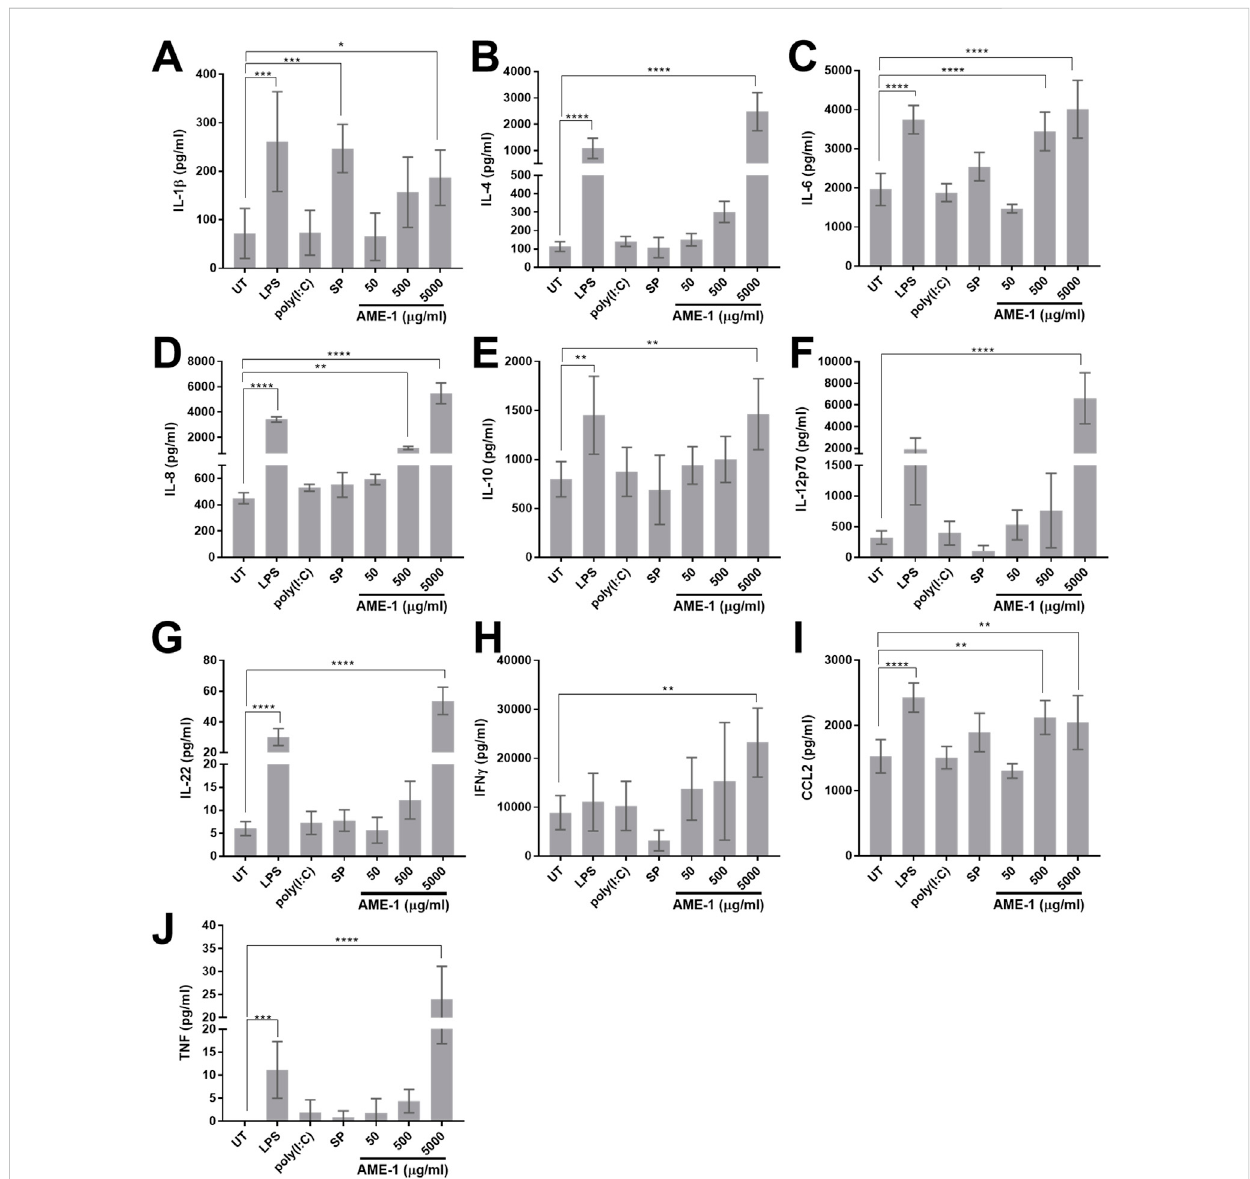
FIGURE 5 AME-1signi fi cantlyincreasesproductionofvariouscytokines.HMC3werestimulatedwith1 µg/mLLPS,0.5 µg/mLpoly(I:C),0.5 µg/mLsubstanceP (SP),orleftuntreated(UT)for24 h.Cellfreesupernatantswerecollectedandanalyzed via electrochemiluminsescentanalysisfor (A) IL-1 β , (B) IL-4, (C) IL- 6, (D) IL-8, (E) IL-10, (F) IL-12p70, (G) IL-22, (H) IFN- γ , (I) CCL2 and, (J) TNF release. Data presented as mean ± SEM for n = 3. Statistical signi fi cance was calculated using one-way ANOVA with Tukey post hoc analysis: p ≤ 0.05 (*), p ≤ 0.01 (**), p ≤ 0.001 (***), p ≤ 0.0001